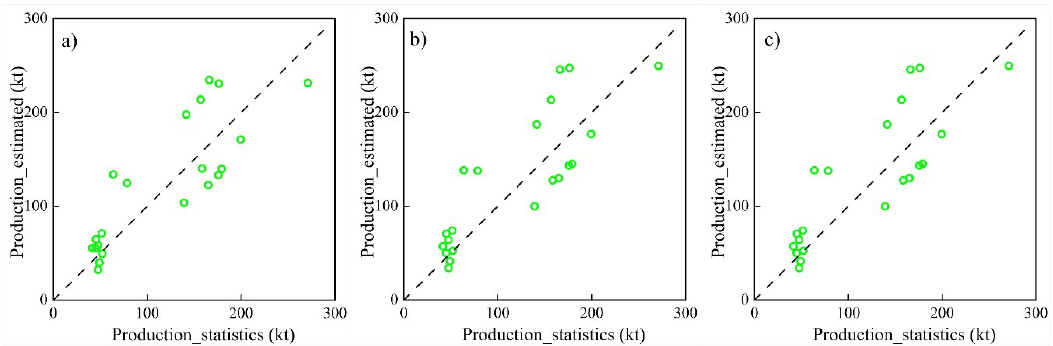
Figure 6. Comparisons of statistical and estimated maize production at the county level using models 1 ( a ), 2 ( b ) and 5 ( c ).